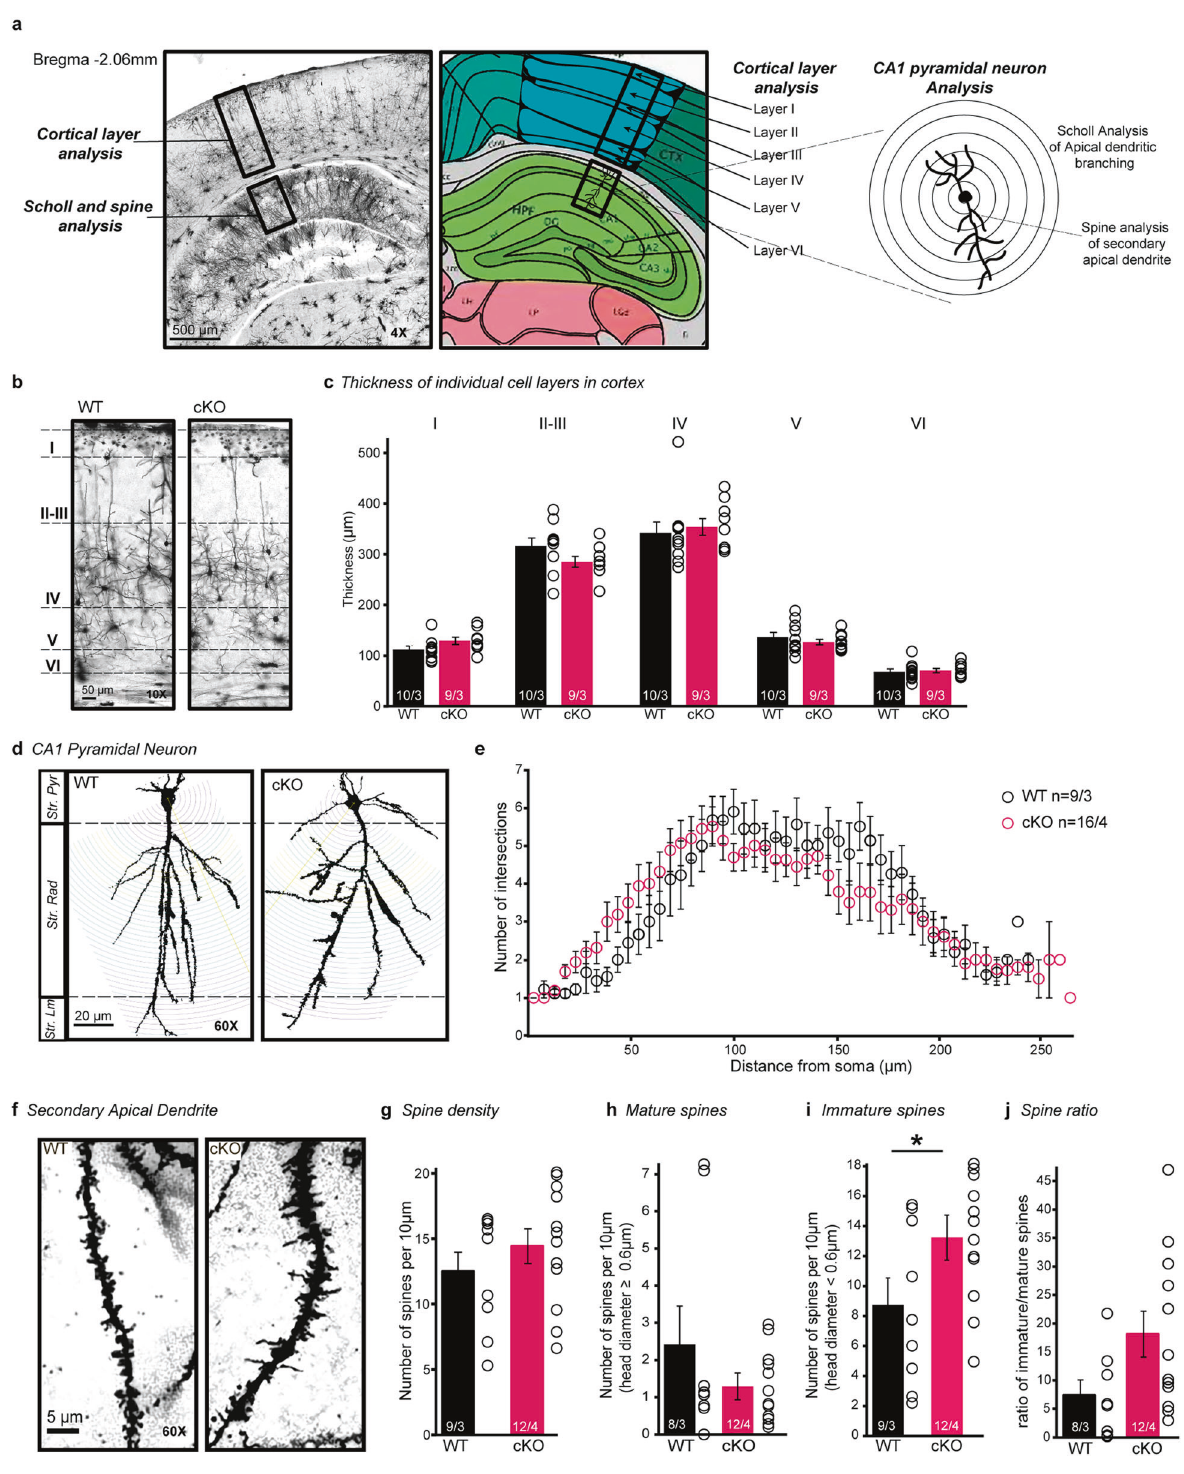
that the increased immature spine density may not be functional or does not in fl uence overall synaptic function. Studies have shown that the morphological changes of dendritic spines (e.g., enlargement of the dendritic spine head) are essential for long- term potentiation and memory consolidation, which allows for AMPAR insertions in response to stimulations (e.g., electrical stimulation in brain slices or through learning) [61, 62]. The small trend towards an increased ratio of immature to mature spines in Translational Psychiatry (2023)